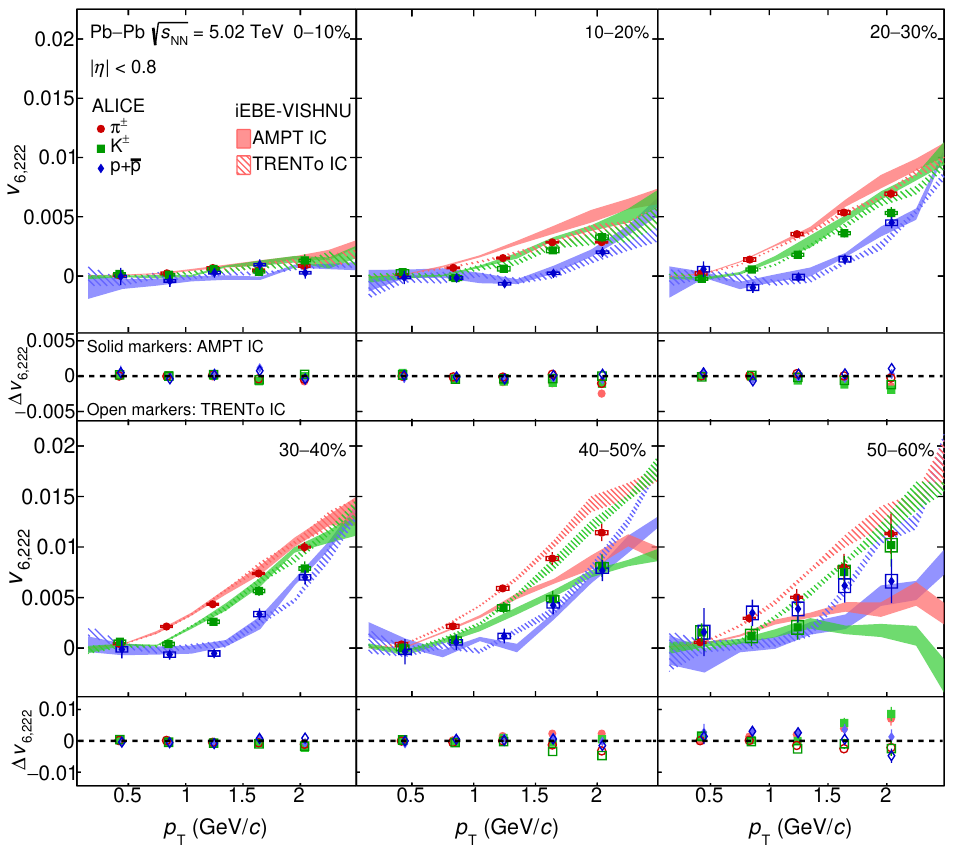
Figure 18 . The p T -di(cid:11)erential v 6 ; 222 of (cid:25) (cid:6) , K (cid:6) and p + p in the 0{10% up to 50{60% centrality p intervals of Pb-Pb collisions at s NN = 5 : 02 TeVcompared with iEBE-VISHNU hybrid models with two di(cid:11)erent sets of initial parameters: AMPT initial conditions ( (cid:17)=s = 0.08 and (cid:16)=s = 0) shown as solid bands and TRENTo initial conditions ( (cid:17)=s (T) and (cid:16)=s (T)) as hatched bands. The bottom panels show the di(cid:11)erence between the measurements and each model. Statistical and systematic uncertainties are shown as bars and boxes,